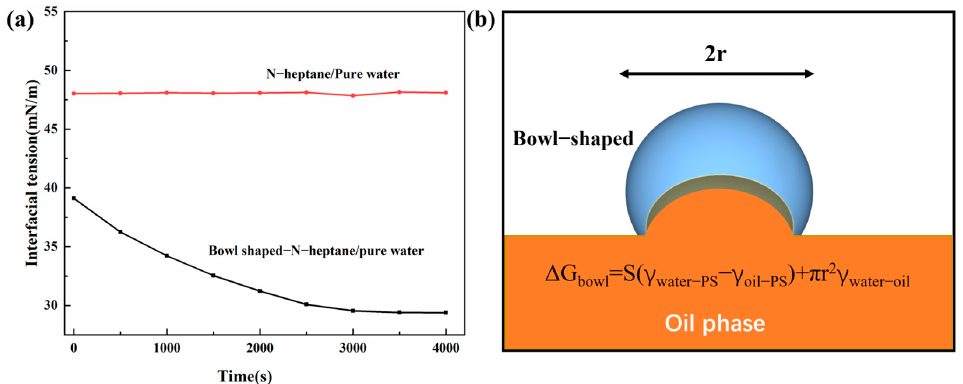
Figure 10. ( a ) Interfacial tension versus time. ( b ) Schematic of a bowl-shaped Janus particle at the oil–water interface.